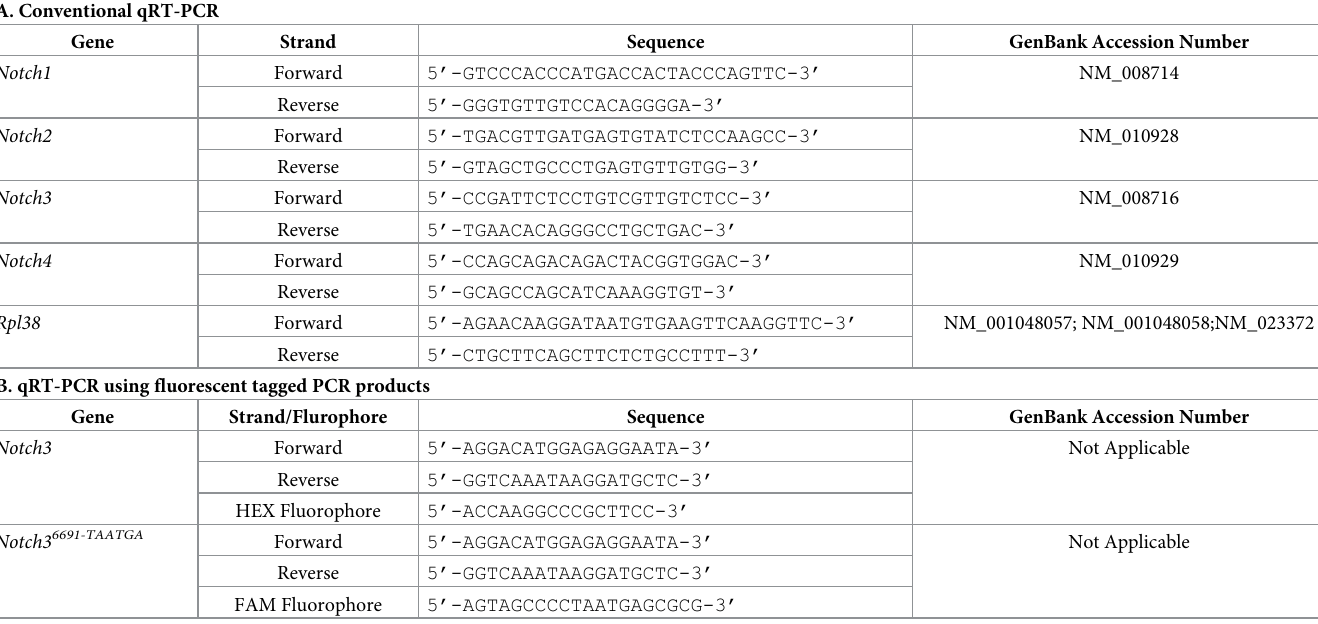
Table 1. Primers used for qRT-PCR determinations. GenBank accession numbers identify transcript recognized by primer